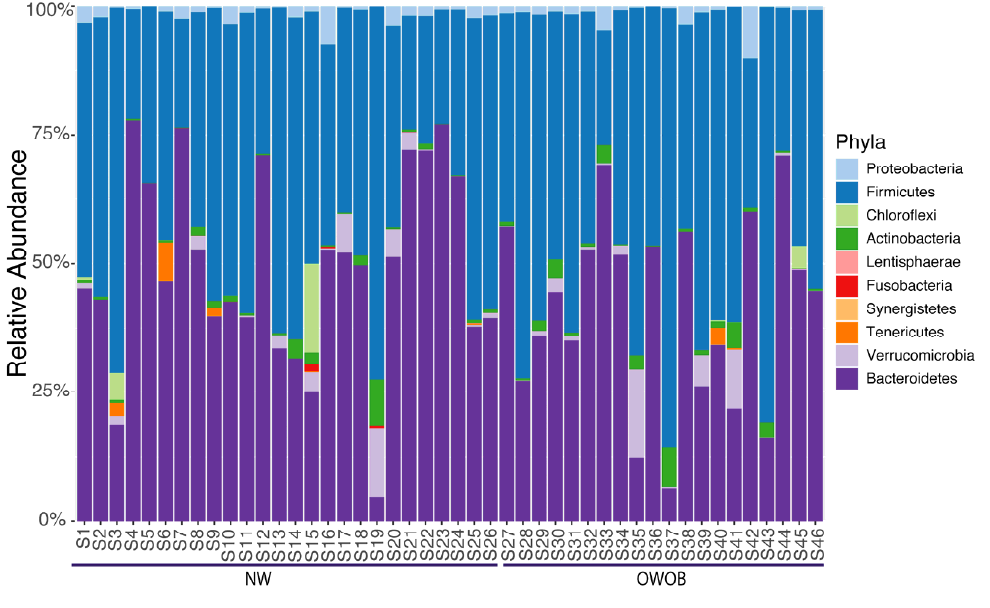
Figure 1. Phylum relative abundance of the 46 samples included in this study ordered by BMI.